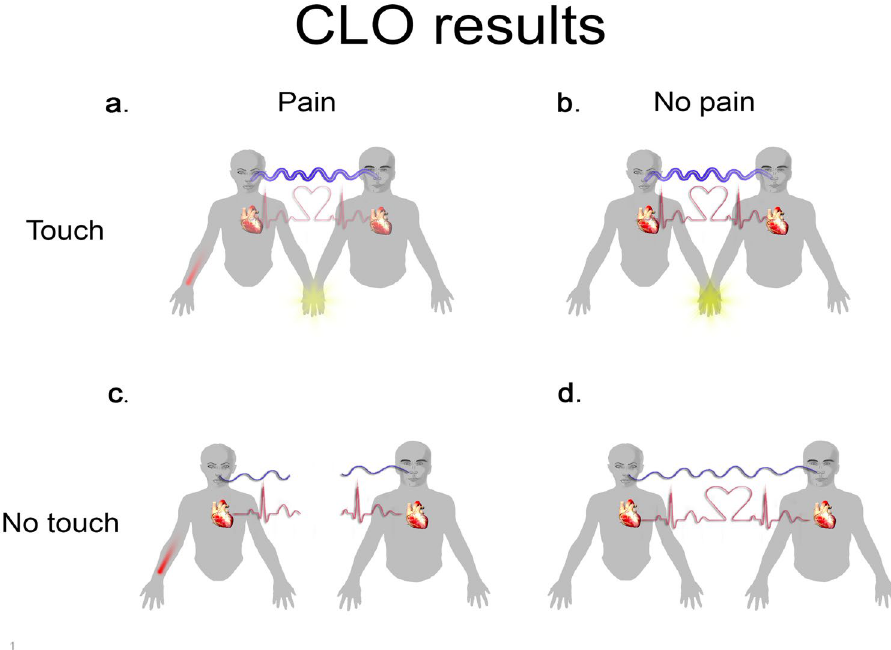
Figure 3. Graphical representation of Coupled Linear Oscillator (CLO) model findings for heart rate and respiration (Fig. 2). Blue lines represent respiration inter-partner coupling and red lines represent coupling in heart-rate. The line’s thickness represents the strength of the coupling, with broken lines denoting a total lack of the coupling. ( a ) Coupling of respiration and heart rate during touch-pain condition. ( b ) Coupling of respiration and heart rate during touch-no pain condition. ( c ) No coupling of respiration and heart rate during no touch- pain condition. ( d ) Coupling of respiration and heart rate during no touch-no pain